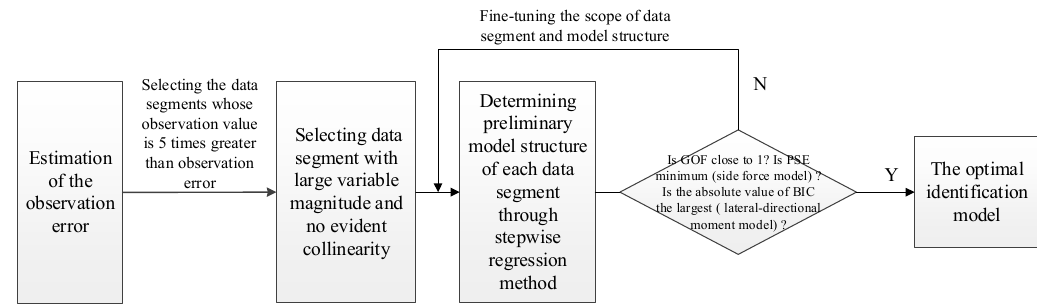
Figure 3. The flow diagram of data segmentation and model adaptation method.